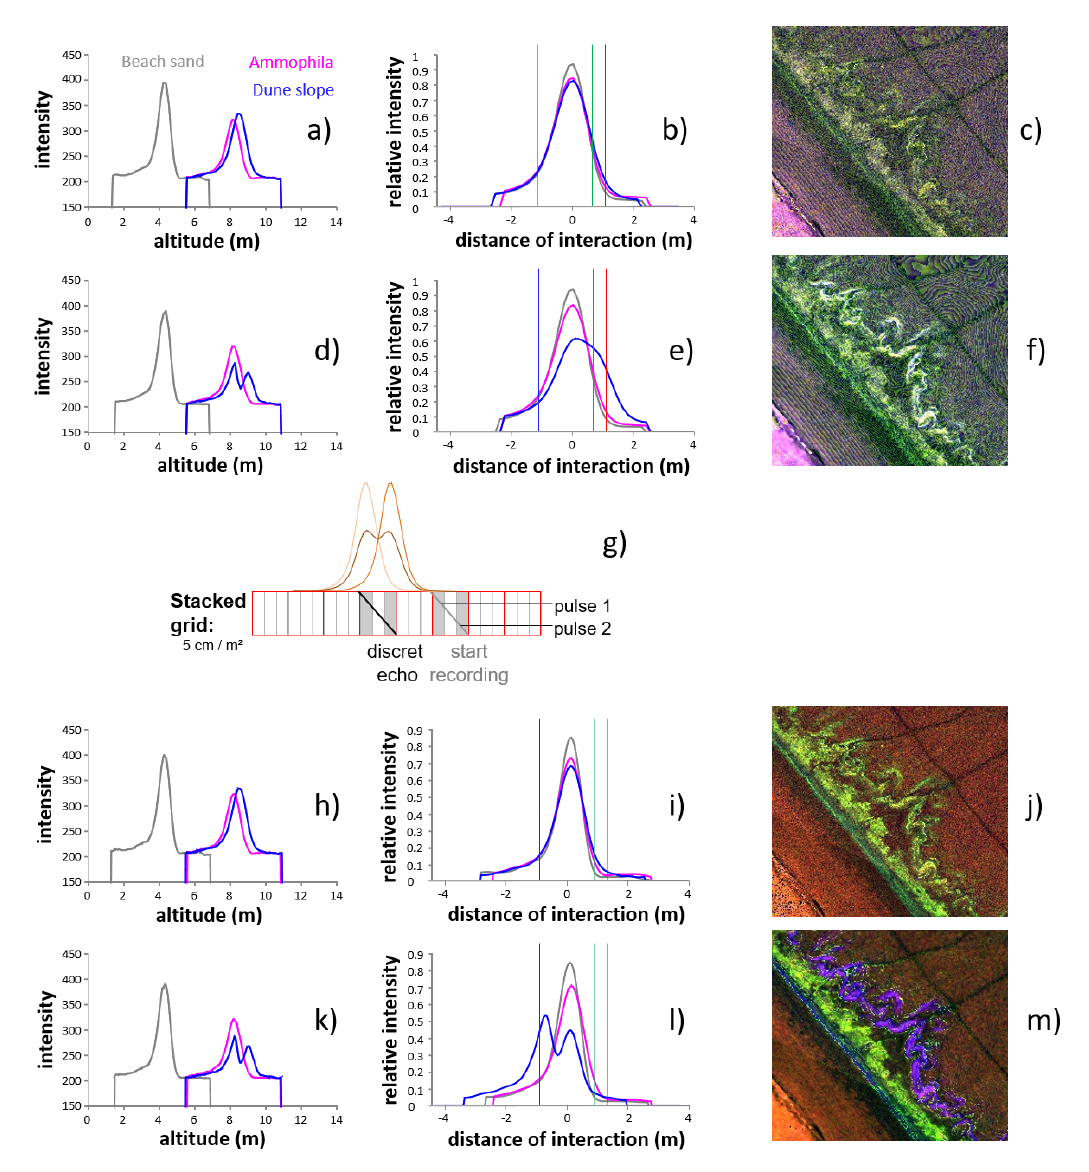
Figure 6. Procedures of FWF signal quality improvement: ( a ) raw 15 cm resolution FWF of beach dry sand ( grey ), Ammophila arenaria ( magenta ) and dune slope ( blue ); ( b ) FWF low-pass filtering with red green and blue channel selection of ( c ) the corresponding color composite image; ( d ) same raw FWF signals with a median filter discussed in the text; ( e ) FWF median results with low-pass and ( f ) its color composite display; ( g ) sketch of the 15 to 5 cm procedure discussed in the text; ( h ) raw 5 cm resolution FWF; ( i ) with low-pass and ( j ) its corresponding color composite display; ( k ) combination of 5 cm resolution and median filtering of the FWF; ( l ) with low-pass filter and ( m ) its corresponding color composite